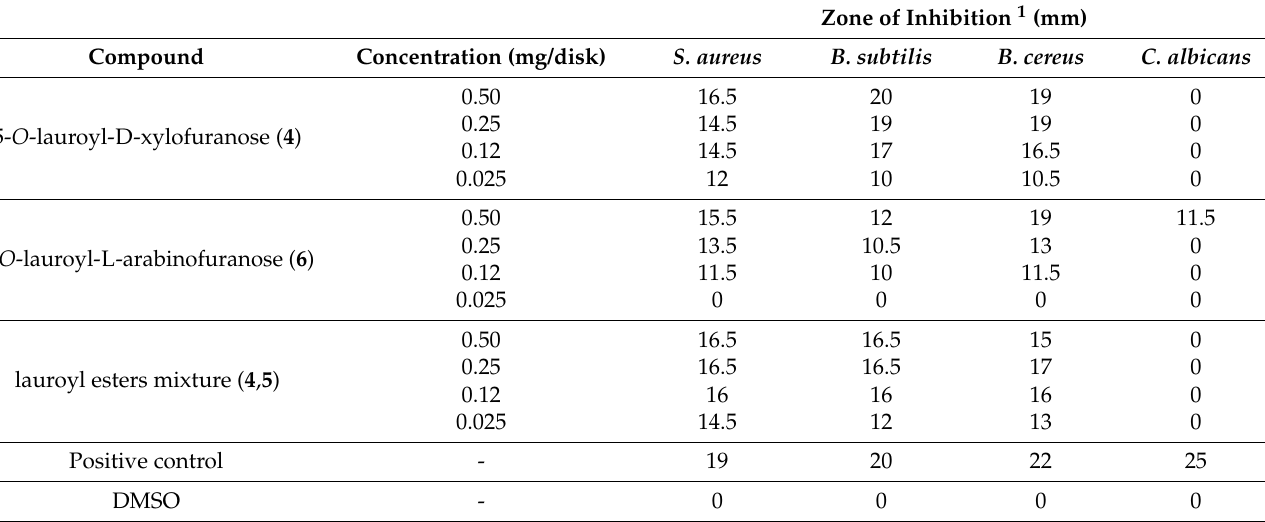
Table 2. Antimicrobial activity of esters at concentration of 0.50 mg/disc, 0.25 mg/disc, 0.12 mg/disc and 0.025 mg/disc.